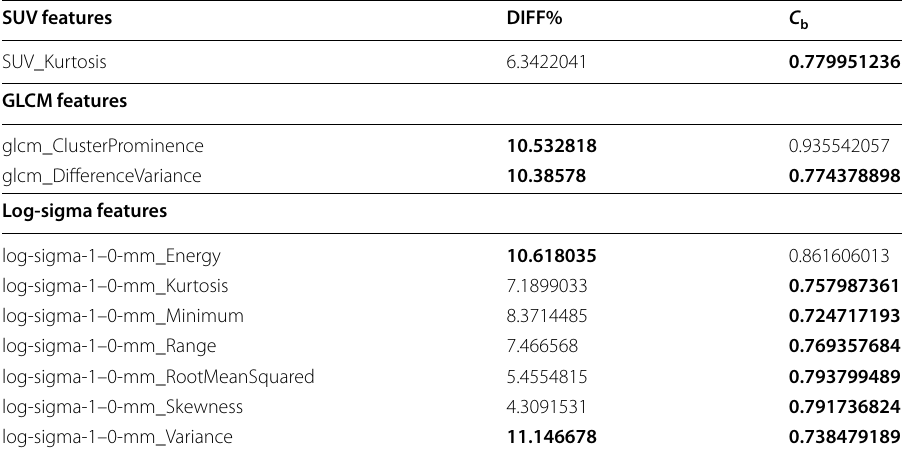
Bold typeface indicates which value from DIFF% and/or C b are non reproducible (DIFF>10%, C b <0.80)